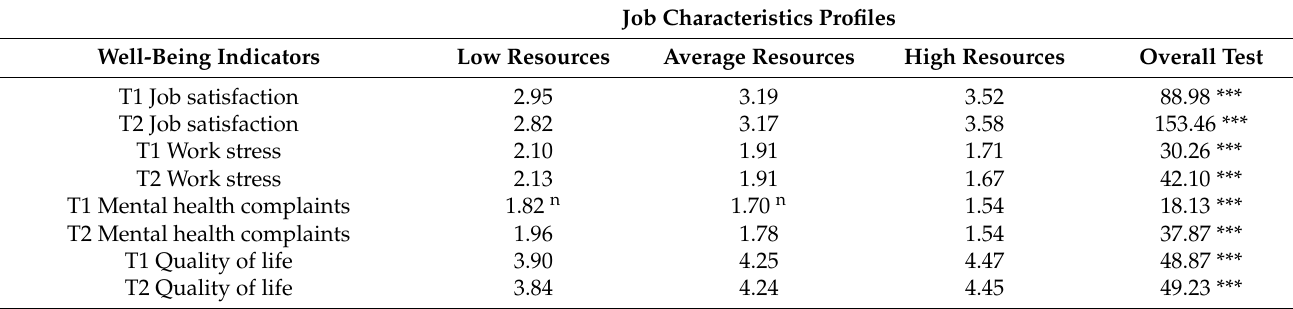
Figure 1. The final three-profile solution after imposing invariance constraints over time in LTA. For easier interpretation, the graph is based on z scores. Profile 1 = Low resources profile. Profile 2 = Average profile. Profile 3 = High resources profile. Percentages before the slash indicate the size of the profiles at Time 1. Percentages after the slash indicate the size of the profiles at Time 2. Table 3. Cross-sectional differences in employee well-being across the job characteristics